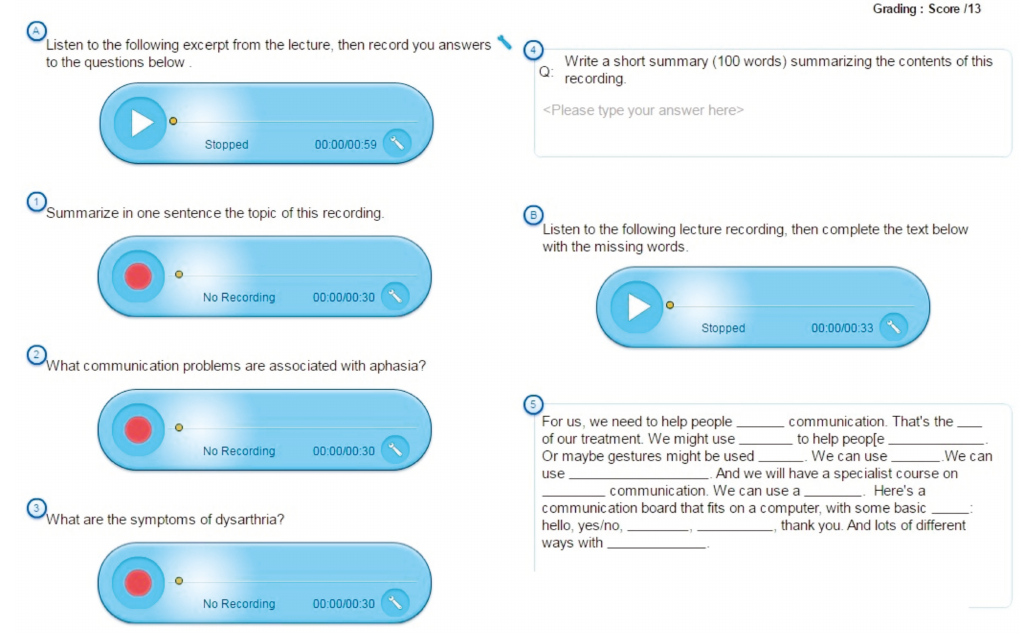
Figure 3. Schoolshape (Schoolshape Limited, La Garenne, Le Catillon, Grouville, Jersey JE3 9UR) activities. Used with